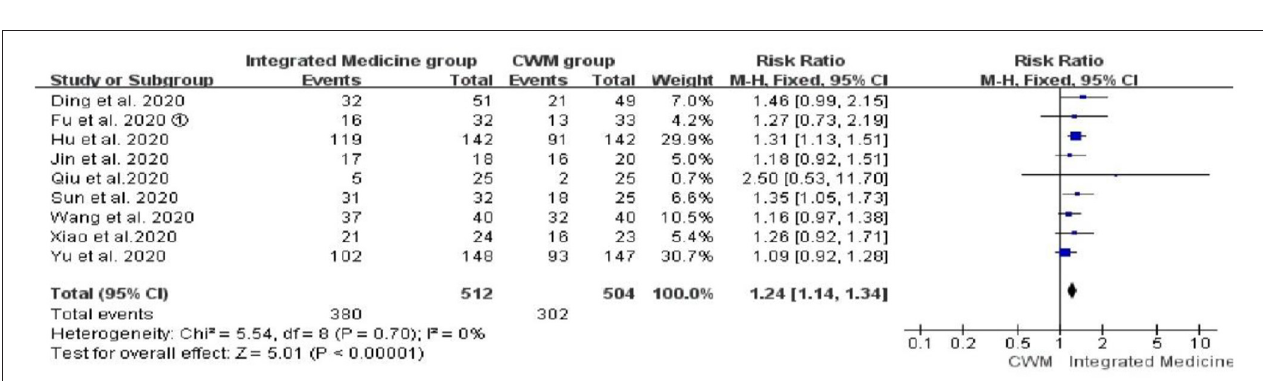
FIGURE 5 | Forest plot of chest CT improvement